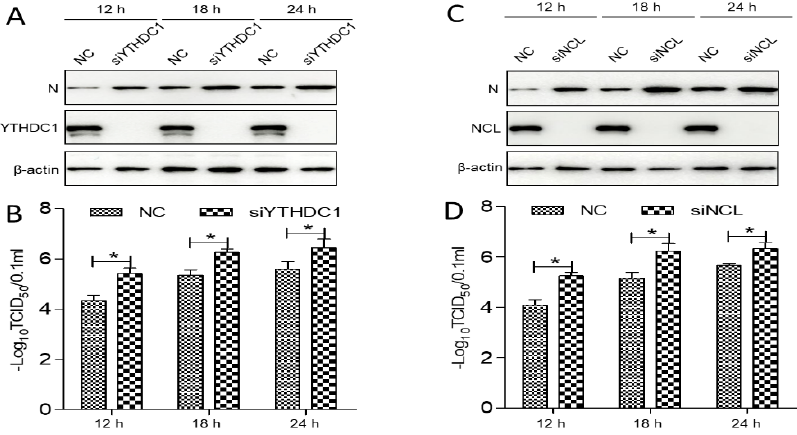
Figure 7. The YTHDC1 and NCL expression inhibited PEDV replication. ( A , C ) The YTHDC1 -silenced or NCL -silenced IPEC-DQ cells were infected with PEDV at a MOI of 0.5 for 12, 18, and 24 h. The cell lysates were analyzed by immunoblotting to examine protein levels of N, YTHDC1, NCL, and β -actin. ( B , D ) The samples from ( A , C ) were used to measure PEDV replication by determining TCID 50 values. Data are presented as means ± SD of three independent biological experiments. * p < 0.05.